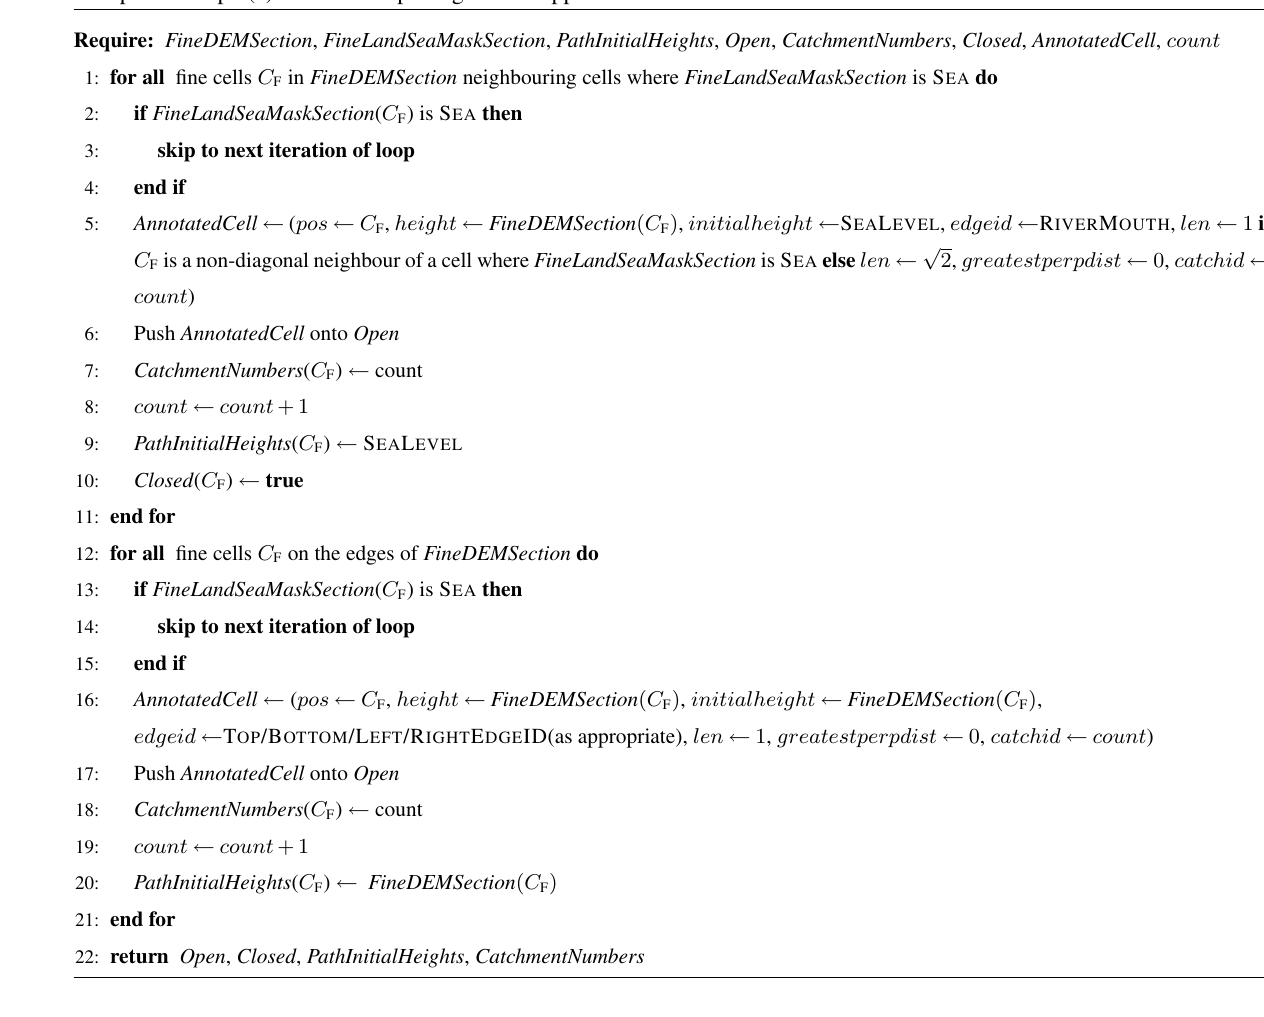
Algorithm 2 Orography upscaling algorithm setup